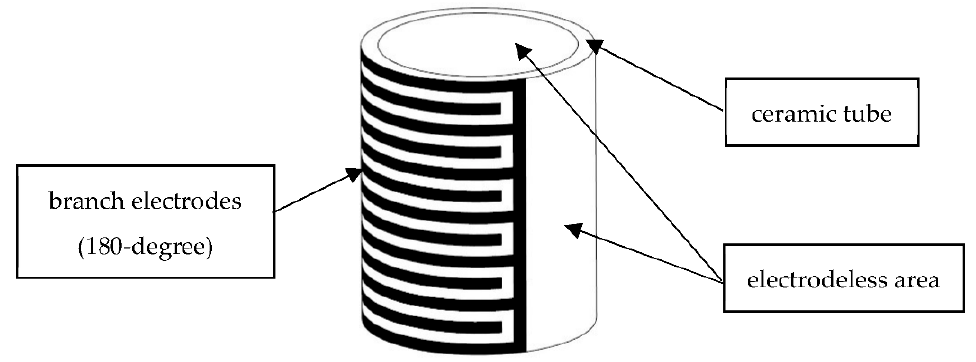
Figure 1. The schematic of piezoceramic tube actuator.